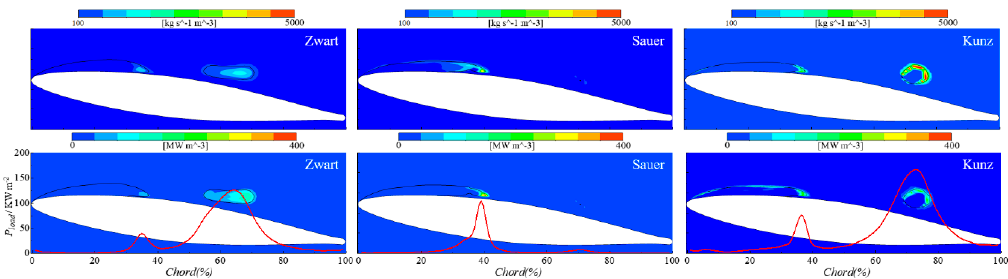
Figure 11. Results obtained with the Zwart ( left ), Sauer ( middle ) and Kunz ( right ) models at instant T / T ref = 0.5 comprising contours of m from vapor to water ( top ) and contours of power density and value of the power load on the surface along the chord (red line in bottom graphs). Black isolines of α v = 0.1 showing the location of the main vapor cavities at each instant.